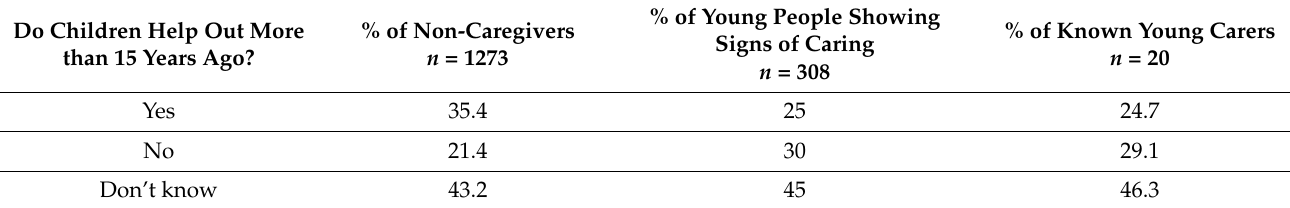
Table 10. Children and young people’s perceptions of whether they have to help out more at